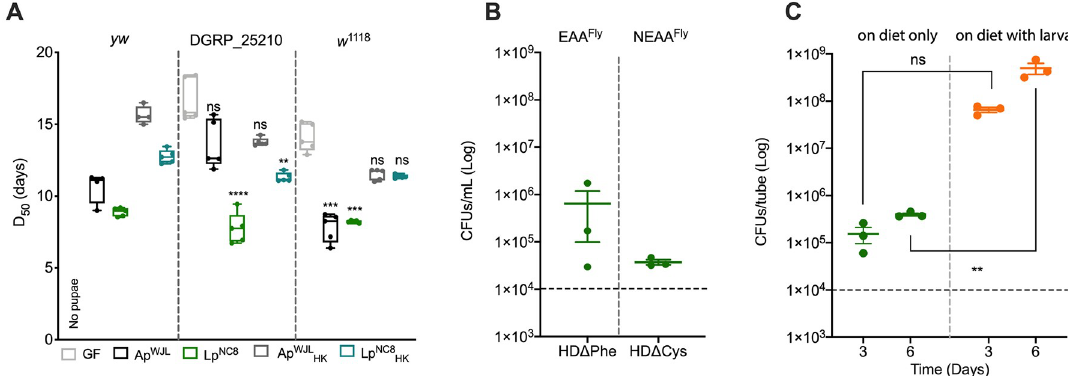
Fig 5. Evaluation of HD Δ Asn, HD Δ Phe, and HD Δ Cys contexts. (A) D 50 of yw , DGRP_ 25210 , and w 1118 larvae on HD Δ Asn. Boxplots show minimum, maximum, and median. Each dot shows an independent replicate. GF yw larvae did not reach pupariation. For the other 2 lines, we performed a Kruskal–Wallis test followed by post hoc Dunn tests to compare each gnotobiotic condition to GF. �� p - value < 0.005, ��� p -value < 0.0005, ���� p -value < 0.0001. (B) Growth of Lp NC8 in liquid HD Δ Phe and liquid HD Δ Cys, in static conditions, 3 days after inoculation. Plot shows mean with standard error. Each dot shows an independent replicate. The dashed line represents the level of inoculation at t = 0 h (10 4 CFUs per mL). (C) Growth of Lp NC8 on solid HD Δ Cys, in absence and in presence of larvae, 3 days and 6 days after inoculation. Plot shows mean with standard error. Each dot represents an independent replicate. The dashed line represents the level of inoculation at t = 0 h (10 4 CFUs per tube). We performed two-way ANOVA followed by post hoc Sidak test. �� p -value < 0.005. Ap WJL , A . pomorum WJL ; CFU, colony-forming unit; DGRP, XXX; D 50 , day when 50% of larvae population has entered metamorphosis; EAA Fly , fly essential amino acid; GF, germ-free; HD, Holidic Diet; HK, heat-killed; Lp NC8 , L . plantarum NC8 ; NEAA Fly , fly nonessential amino acid; ns, nonsignificant; yw , XXX.